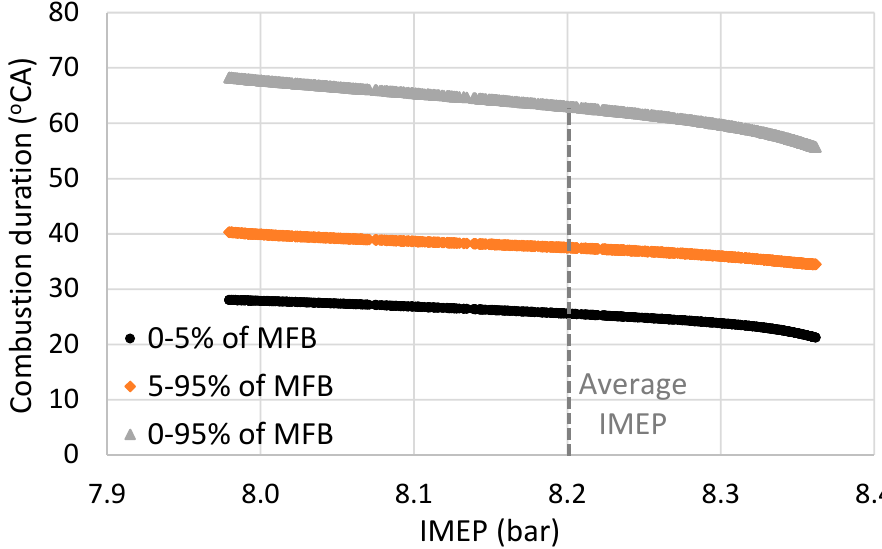
Figure 7. Combustion duration as a function of the IMEP for the case of 1000 cycles.